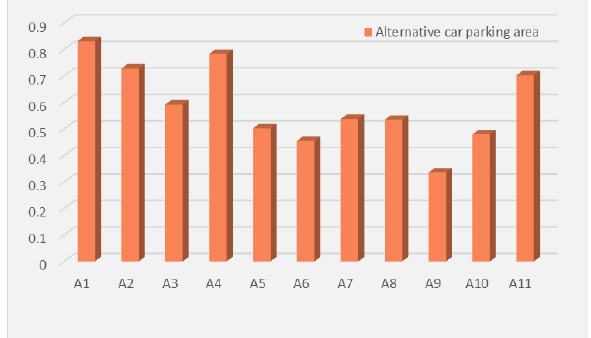
Figure 9. Result of ranking alternative car parking areas by TOPSIS